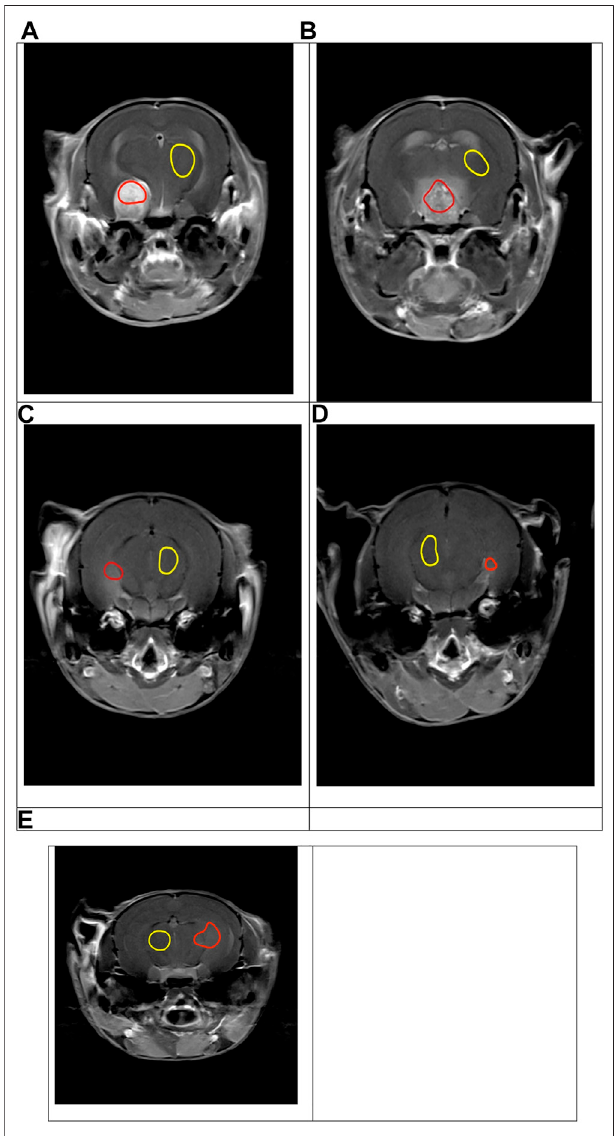
FIGURE 1 | T 1 _TSE_Tra images showing variable tumour growth and gadolinium enhancement in the tumour (red ROI) and in the thalamus (yellow ROI) for mouse 1-5, (A – E)